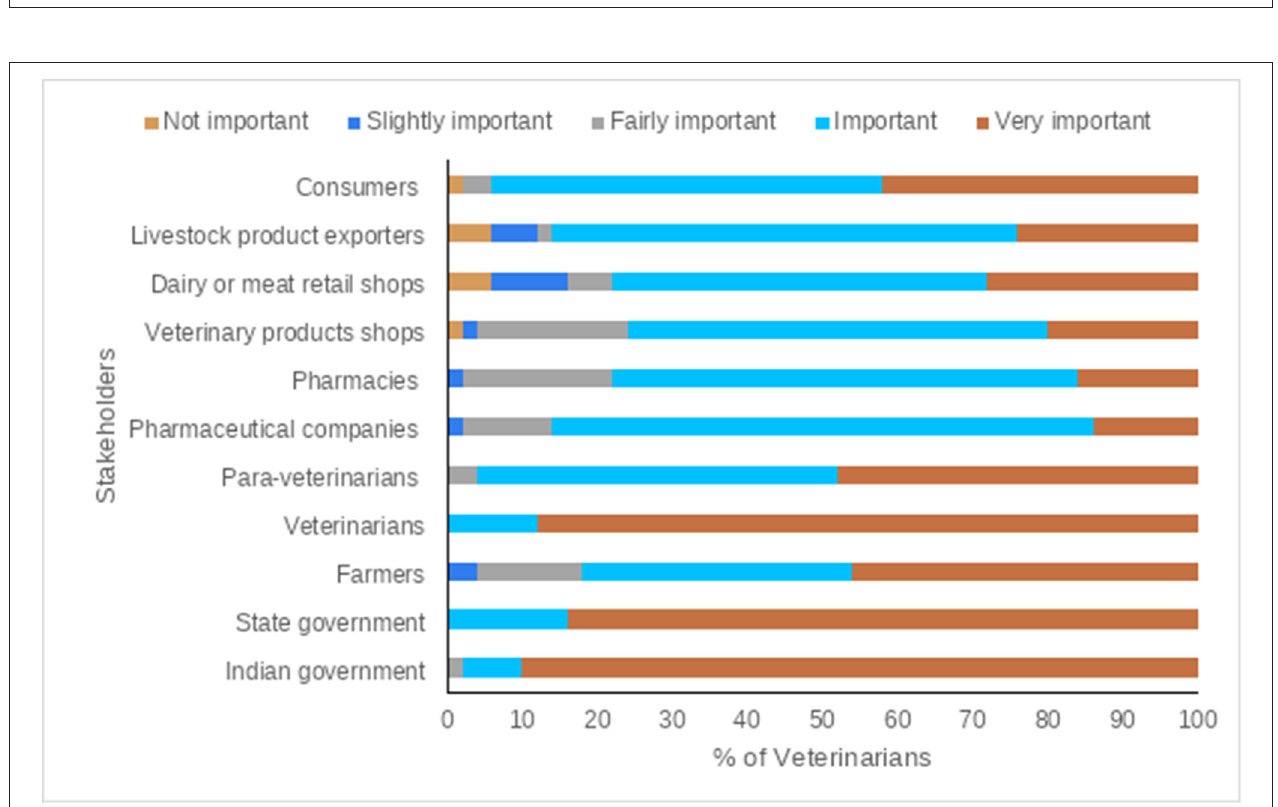
FIGURE 8 | Veterinarians’ opinions of the main stakeholders in the control the excess use of Antibiotics/Antimicrobials.